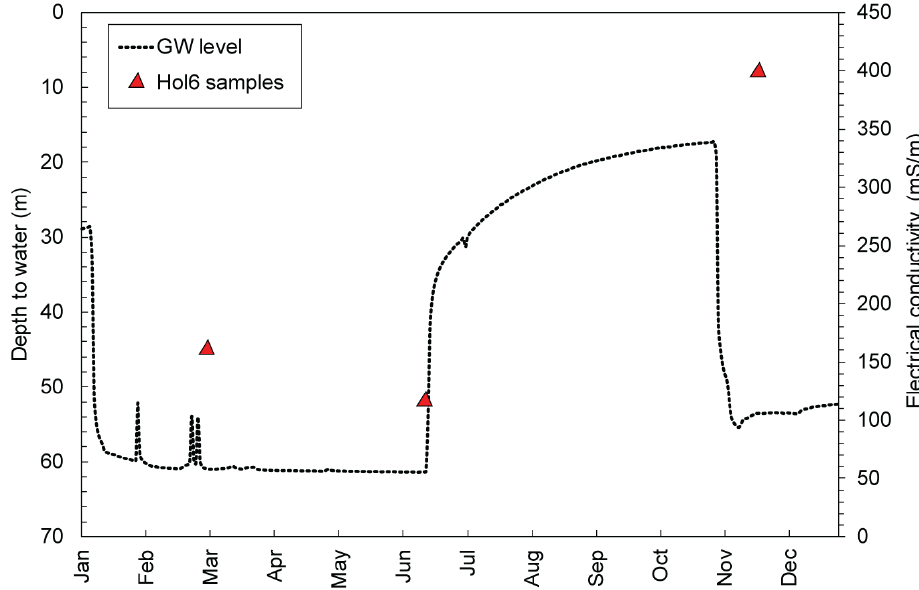
Figure 9. Measured electrical conductivity (EC) and groundwater levels for MG aquifer at location Hol6 for 2016 (after